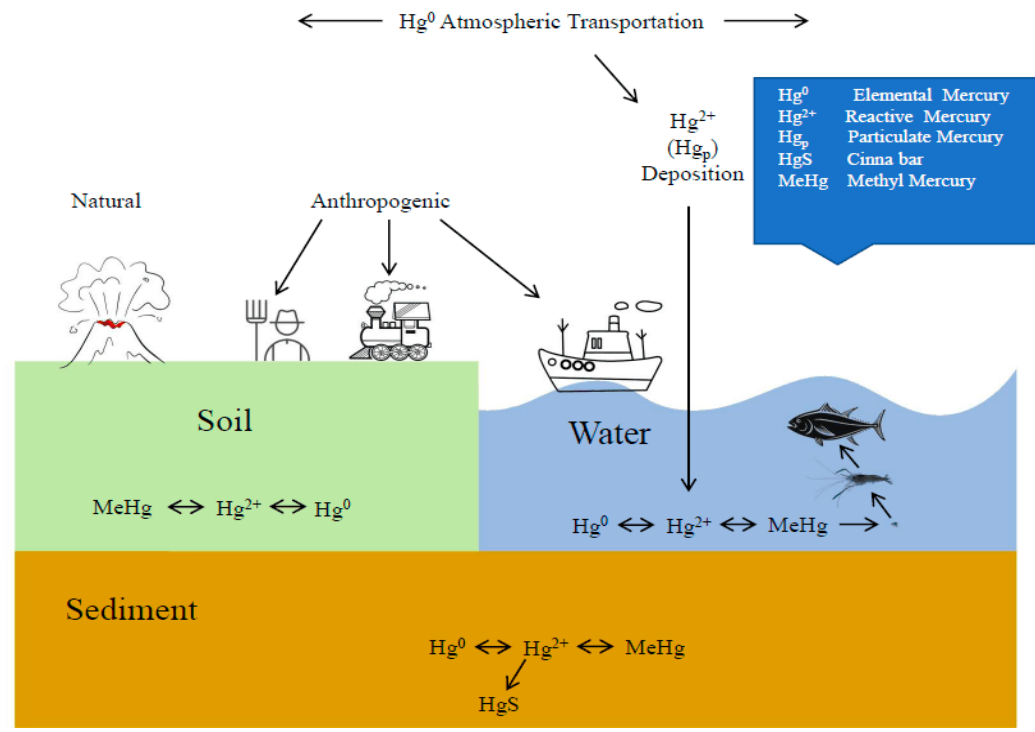
Figure 1. The global mercury cycle as adapted from Lindsay D. Starr [1]. The mercury cycle shows the transportation of Hg through the atmosphere, water, soil, and sediment.